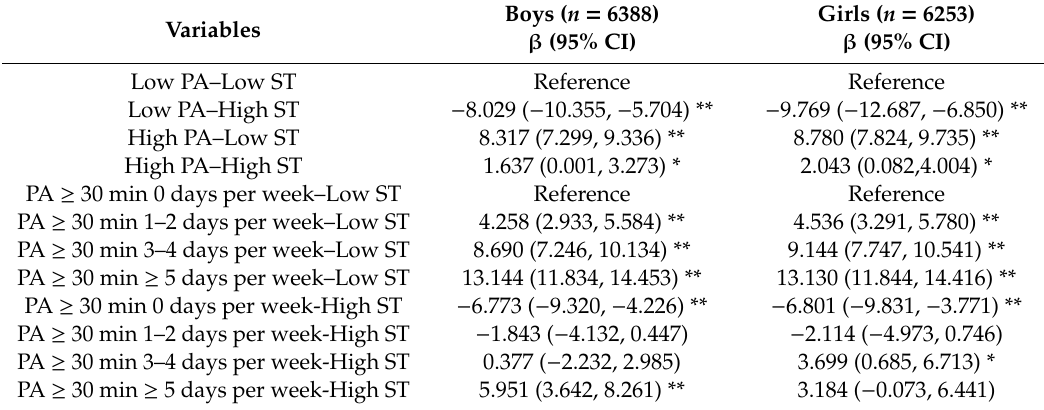
Table 5. Results from the multivariable general linear models evaluating the joint association of physical activity and screen time with total quality of life in adolescents in Boys and